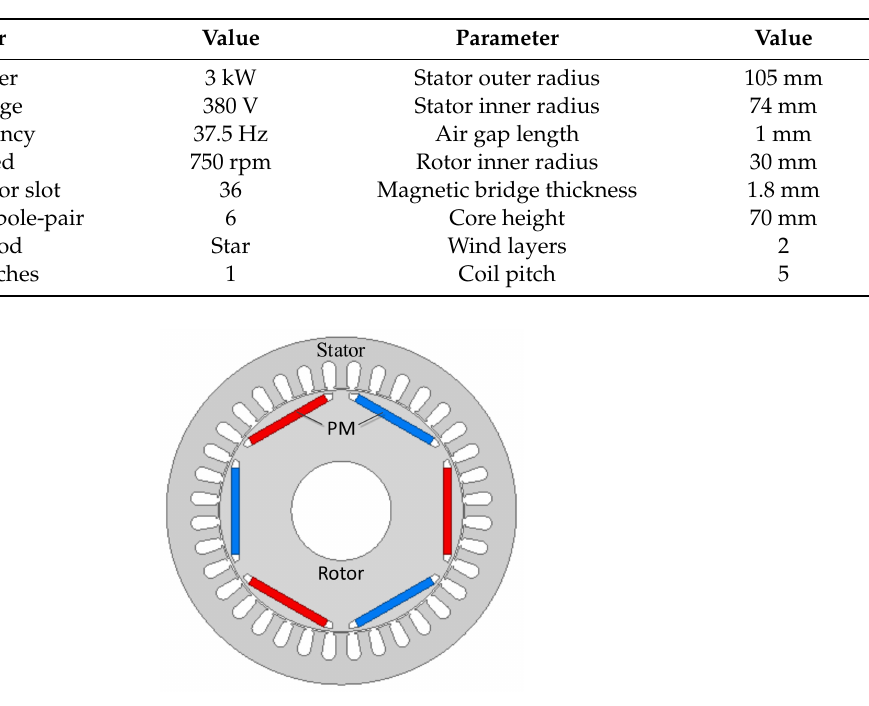
Table 1. The parameters of the prototype motor.